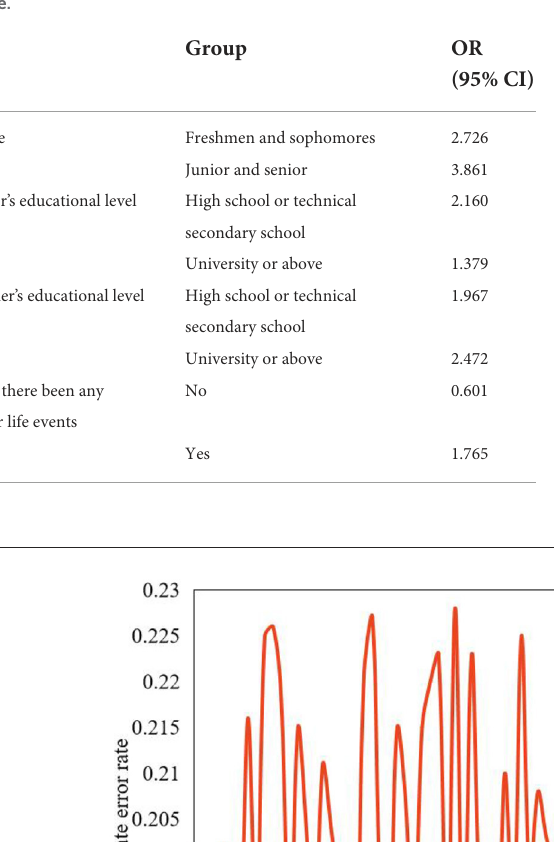
TABLE 4 Multi-factor regression analysis of psychological status score.